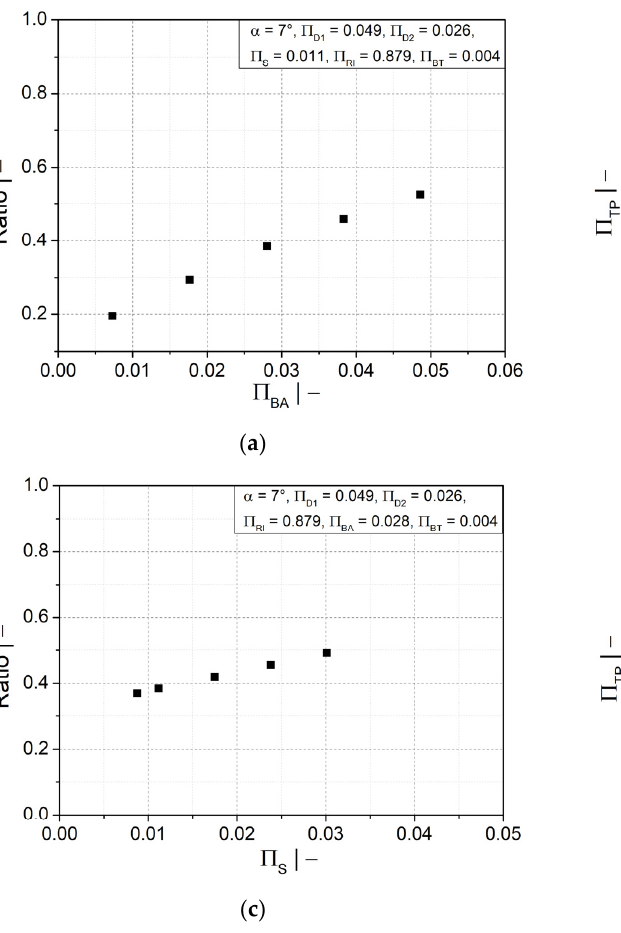
and ( c , d ) initial thickness of fluid parison ∏ (cid:3020) .